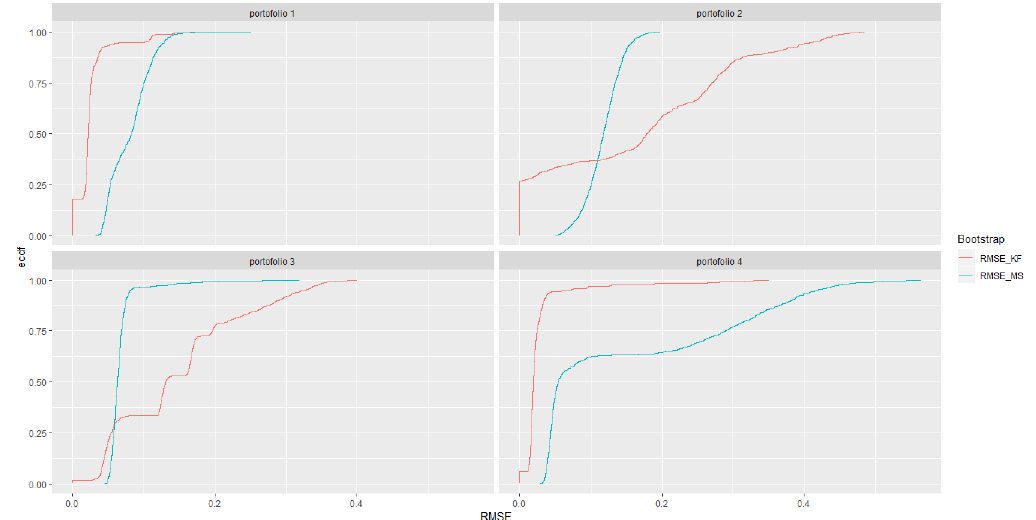
Figure 4. RMSE distribution for the two-factor